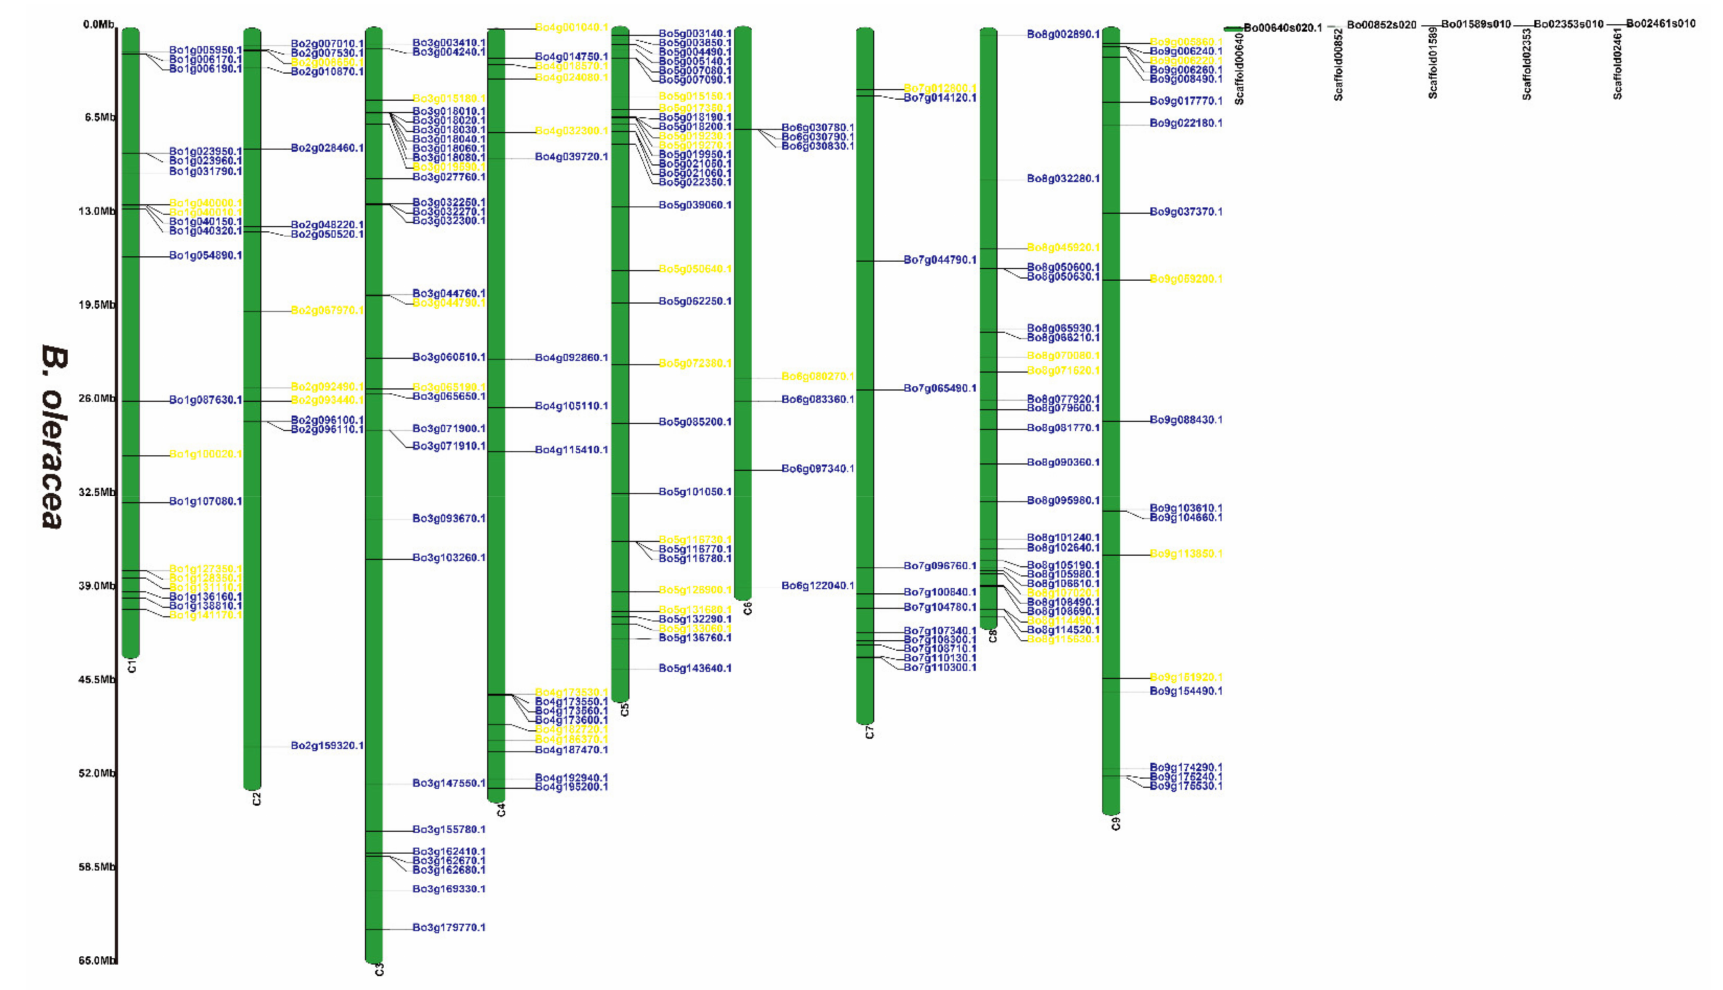
Figure 3. Chromosomal distribution of putative 2OGDs in B. oleracea . Individual 2OGD positions are shown in Mbs along the chromosome scale. The blue label represents the retained gene, the yellow label represents the lost